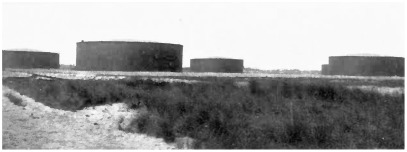
55.000-barrel storage tanks from Mexican Eagle Oil Co., beginning of the 20th century [99].